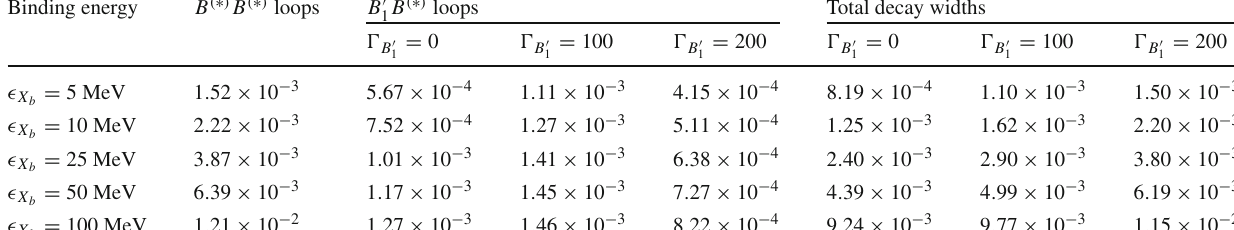
Fig. 2 The dependence of the decay widths of ϒ( 5 S ) → γ X b (a) and ϒ( 6 S ) → γ X b (b)